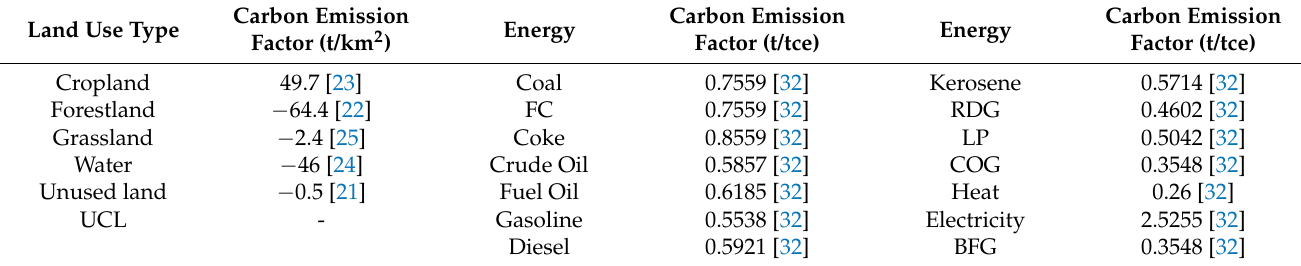
Table 2. Carbon emission coefficients for each type of land use and each major energy